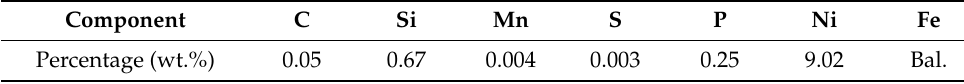
Table 2. Mechanical properties of base metal.